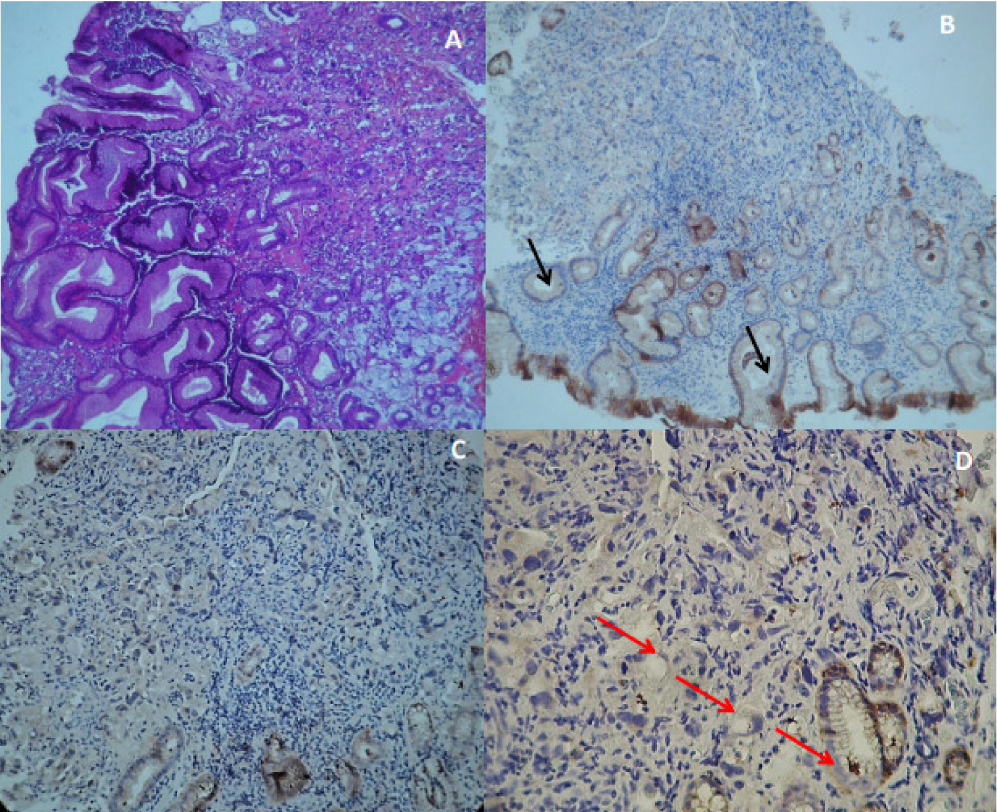
Figure 3. E-cadherin expression status in tumor gastric tissue. ( A ) H and E staining of JI-014 tumor tissue (X100). ( B ) E-cadherin immunostaining expression in gastric tumor tissue (X100). Black arrow shows normal membranous E-cadherin staining in crypt and glandular cells. ( C ) Loss of membranous E-cadherin expression in tumor cells (X200). ( D ) Red arrow shows a loss/reduction of E-cadherin expression in tumor cells and residual glands